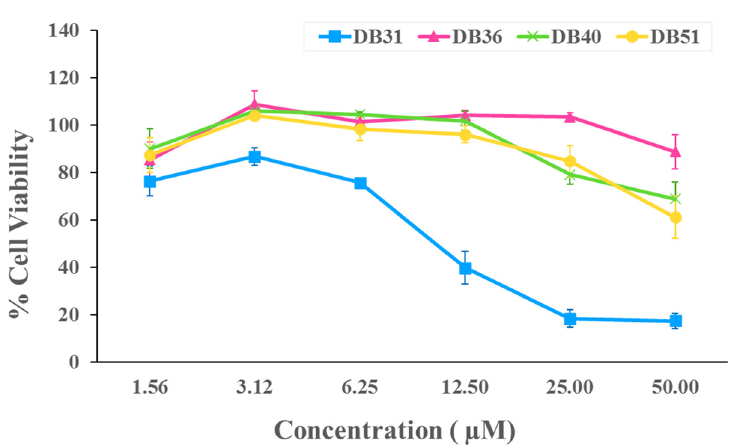
Figure 3. Cytotoxicity of identified hit compounds from in silico screening. HEK293T/17-hACE2 cells were treated with DB31, DB36, DB40, and DB51 at concentrations of 1.56, 3.12, 6.25, 12.50, 25 and 50 µM for 48 h. Cell viability was determined by Cell Counting Kit-8 solution at the optical density of 450 nm. Percent cell viability was calculated by comparing with DMSO. Data are expressed as the relative mean value with an error bar (standard error of the mean, SEM) from three independent experiments (each performed in triplicate) .